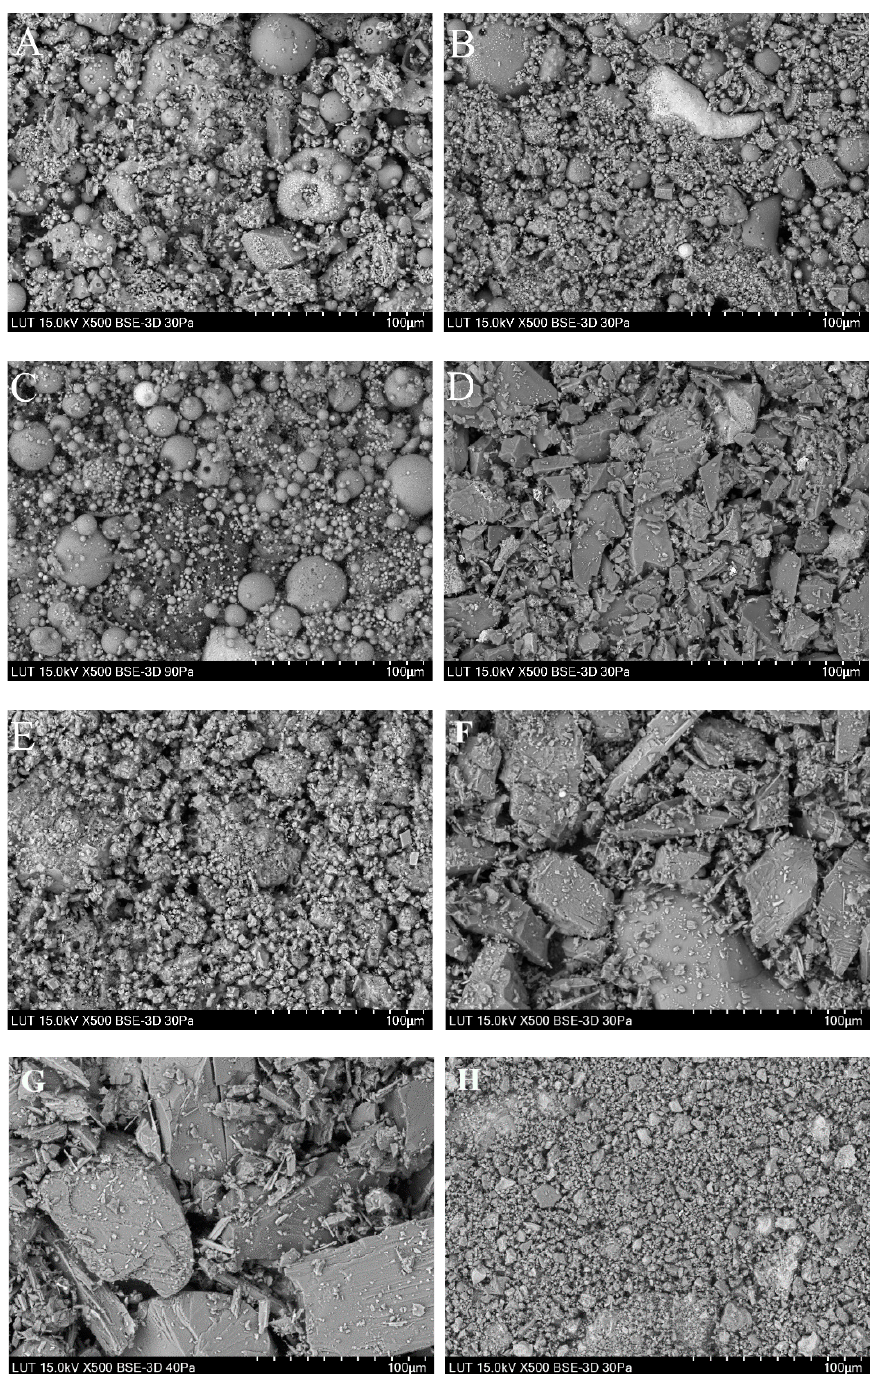
Figure 2. SEM micrographs of the samples, ( A ): biomass fly ash 1 (FA1), ( B ): biomass fly ash 2 (FA2), ( C ): Coal fly ash (FA3), ( D ): bottom ash (BA), ( E ): green liquor dregs (GLD), ( F ): fine limestone tailings (MTF), ( G ): coarse limestone tailings (MT), ( H ): electric arc furnace steel slag (SS).